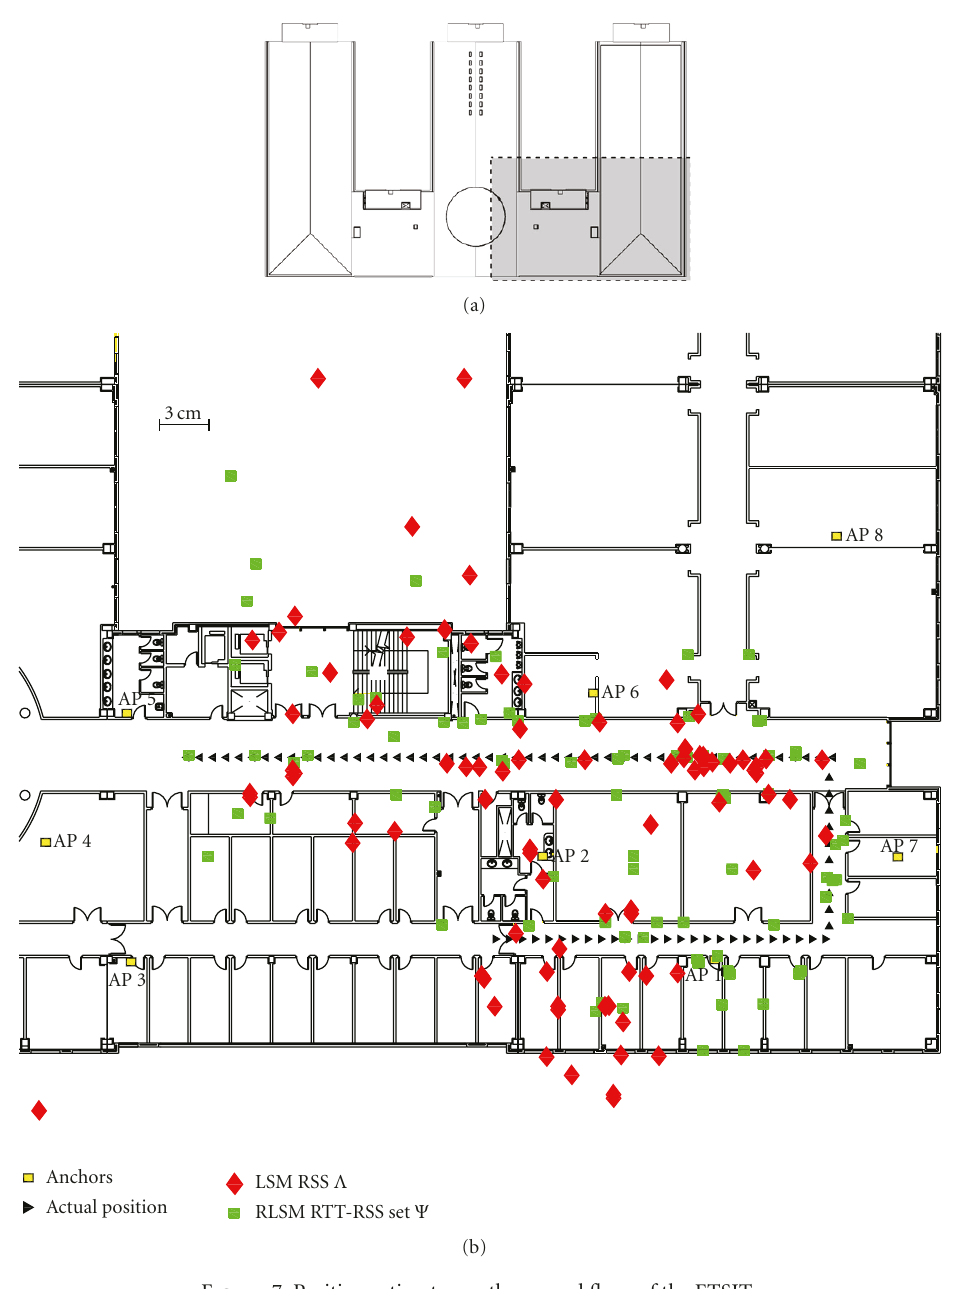
Figure 7: Position estimates on the second floor of the